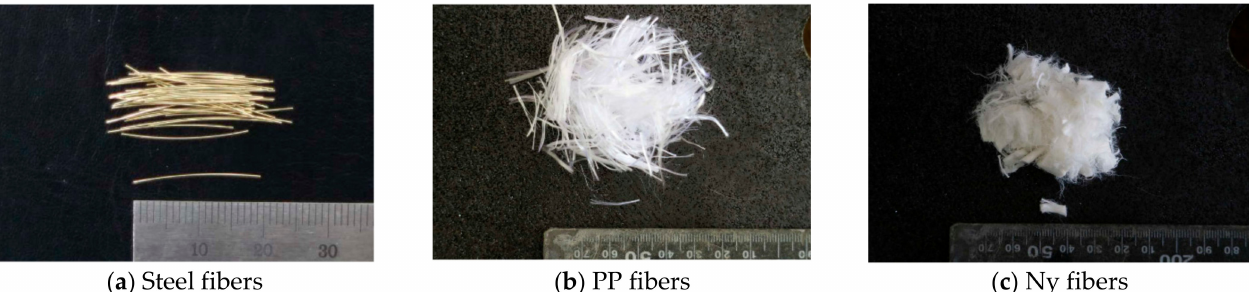
Figure 1. Steel fibers and synthetic fibers are used in high-performance fiber-reinforced cementitious composites (HPFRCC). Table 3. Information on steel, polypropylene (PP), and nylon (Ny) fibers [17,26].